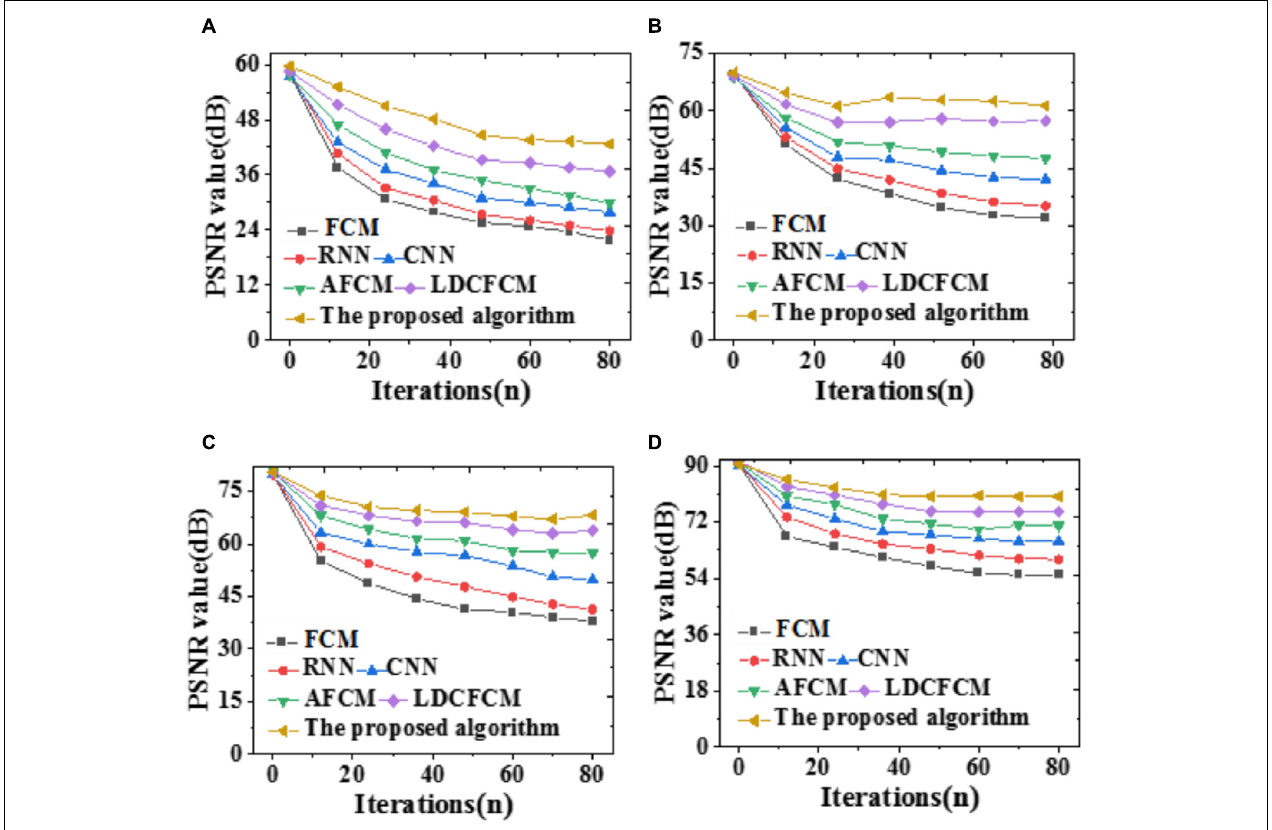
FIGURE 8 | PSNR of the model segmentation results under different brain image noises. (A) 10%; (B) 20%; (C) 30%; (D) 40%.